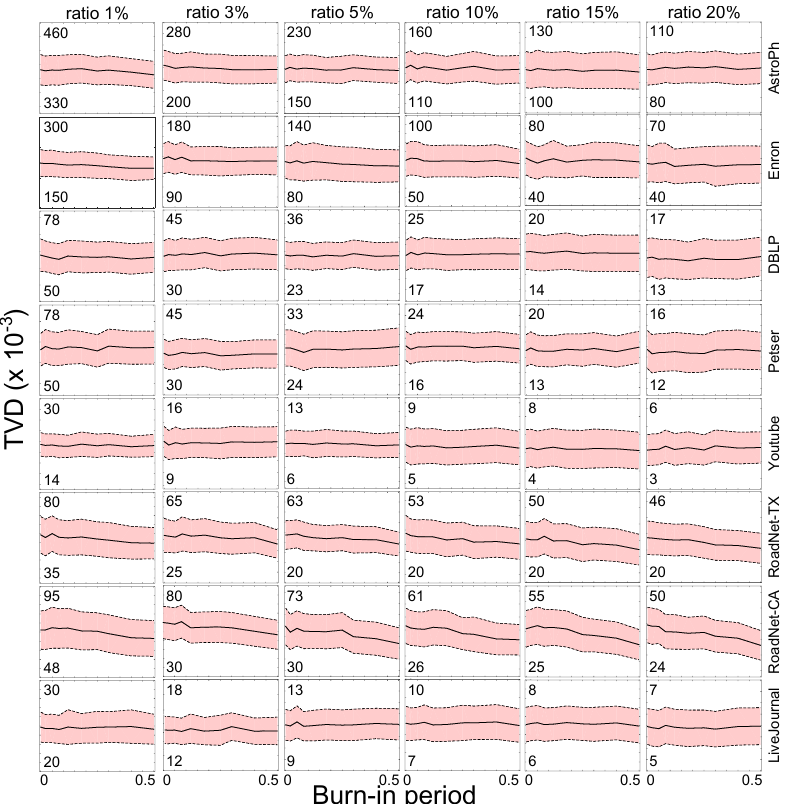
Figure 6. Results of sampling performance for various burn–in